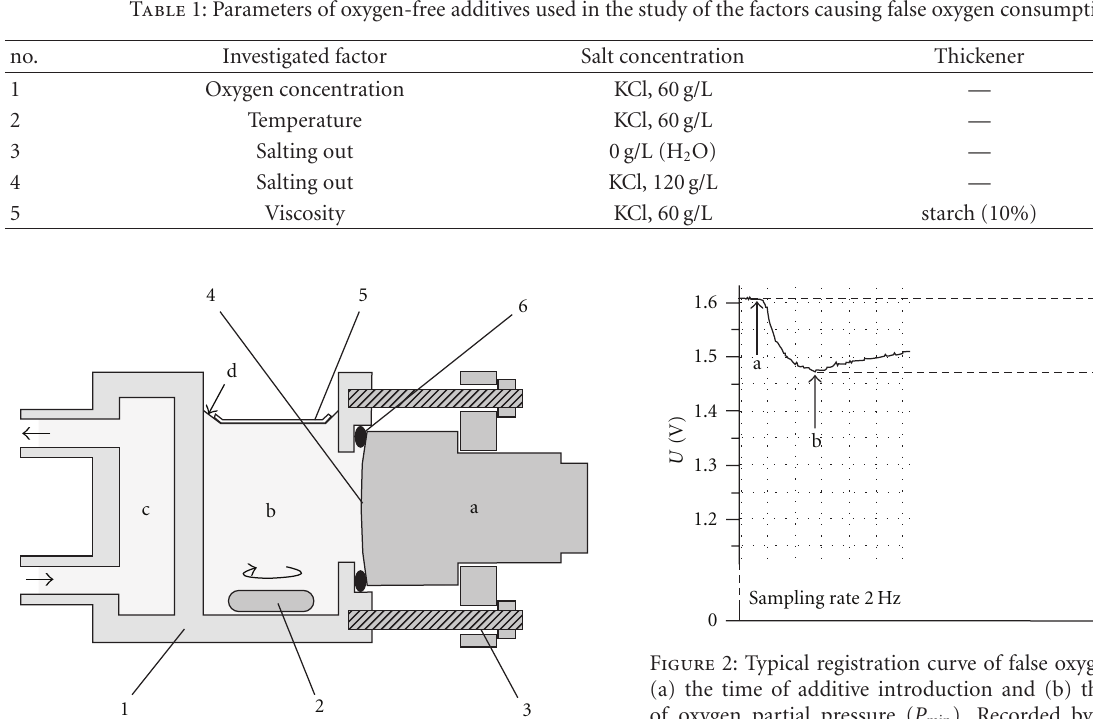
Figure 1: Thermostated measuring cell. (a) oxygen sensor, (b) the incubation medium, (c) water jacket, and (d) a place to introduction of additives. (1) the cell body (PMMA), (2) magnetic stirrer, (3) sensor mount, (4) sensor membrane (Teflon, 20 µ m), (5) floating lid (polyethylene), and (6) gasket (rubber).